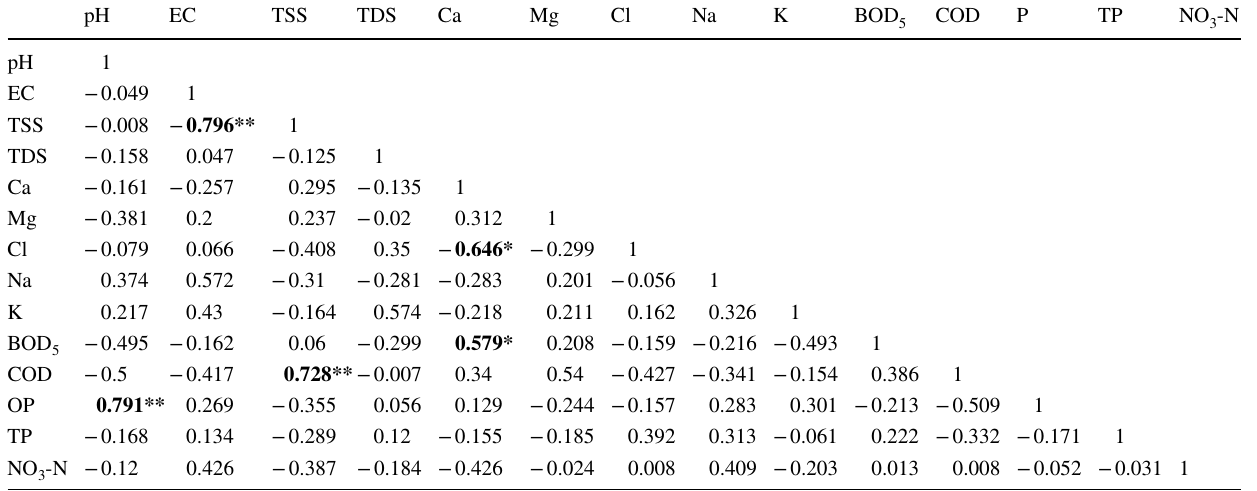
*Significance at 0.05 level and **significance at